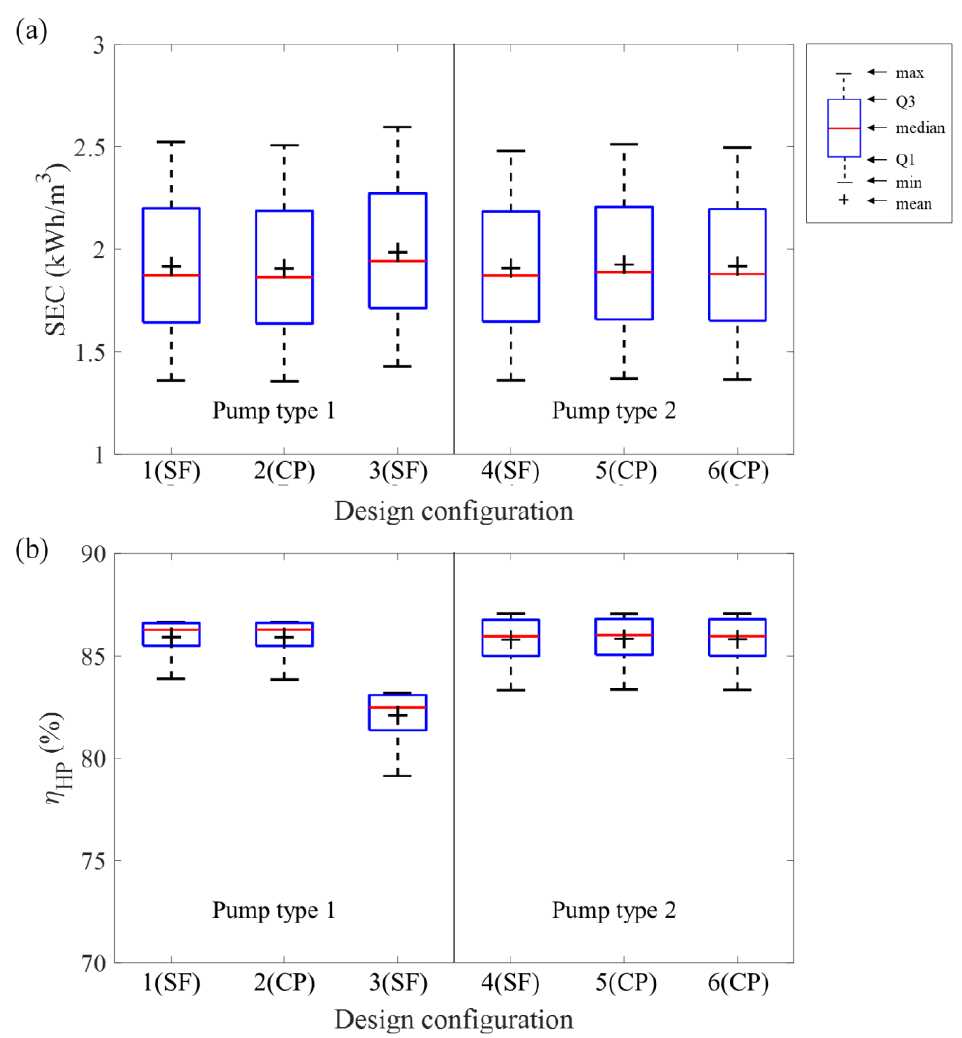
Figure 4. Simulation results depending on the design configuration: the annual statistics for ( a ) high-pressure pump efficiency, ( b ) specific energy consumption. The design configuration from 1 to 3 and design configuration from 4 to 6 are configured with pump type 1 and pump type 2, respectively. It is noted that the Q1 and Q3 in the legend of figure indicate the first and third quartiles, respectively.